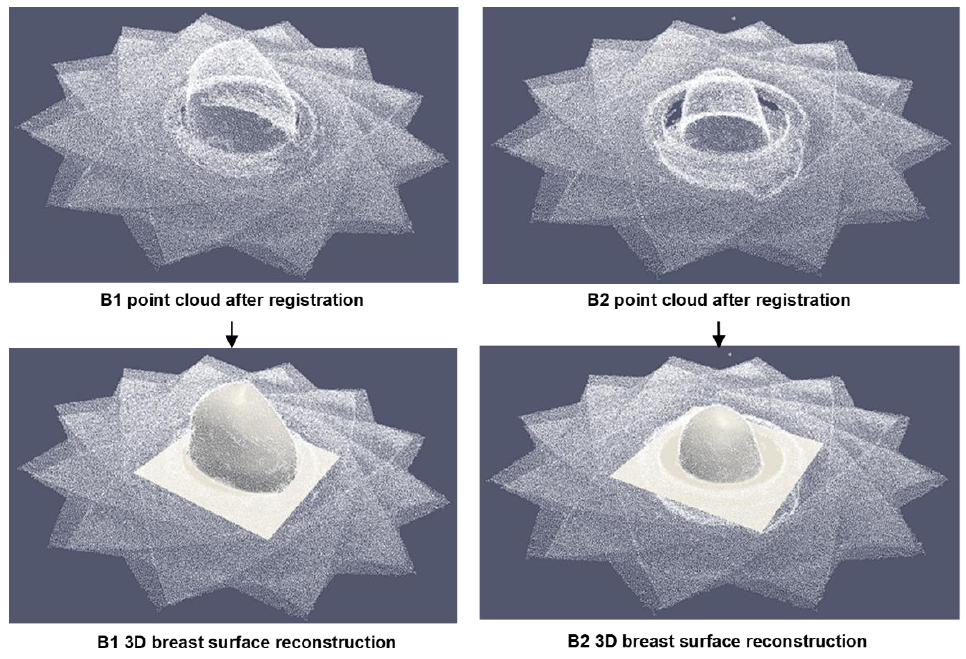
Figure 29. 3D breast reconstructions from point clouds using the Wavelia OBCD breast surface reconstruction method.